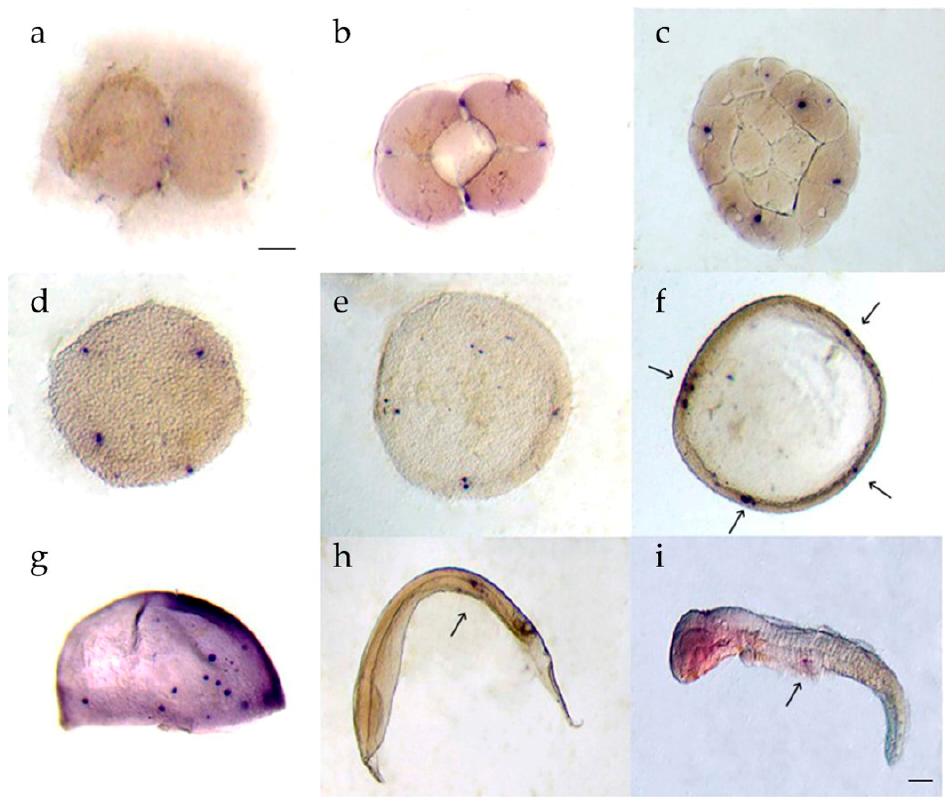
Figure 6. psdnd transcript localization during embryogenesis. Embryos were hybridized with antisense psdnd , stained by purple AP. ( a ) 2 cell stage: psdnd transcripts presented at first cleavage site; ( b ) 4 cell stage: psdnd positive signals revealed the spots where edges of second cleavage; ( c ) 32 cell stage; ( d ) morula stage: four dnd positive signals maintained until morula stage; ( e ) blastula stage: sister cells developed next to origin cells; ( f ) early gastrula stage; dnd transcripts increased and clustered at four spots of germ rings; ( g ) late gastrula stage; psdnd positive signals were move on to body axes; ( h ) early somite stage; ( i ) hatching larva: psdnd transcripts were aggregated and move on to future gonad location. Arrows indicate psdnd transcript expression. Scale bar: 100 µm.